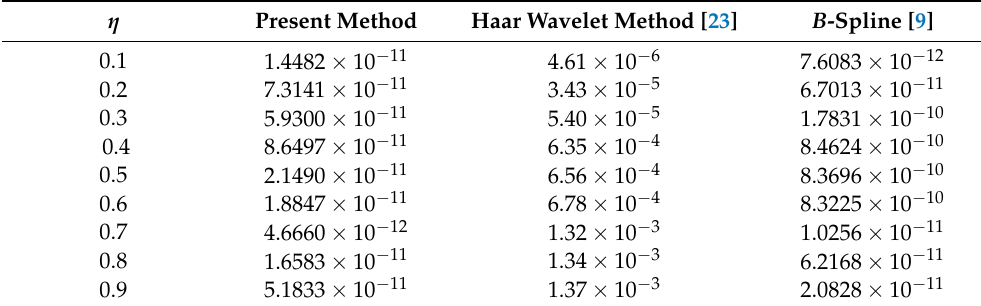
Table 3. Comparison of the proposed method’s absolute error with the HWM and B -spline methods of Example 1 for ζ = 0.001.